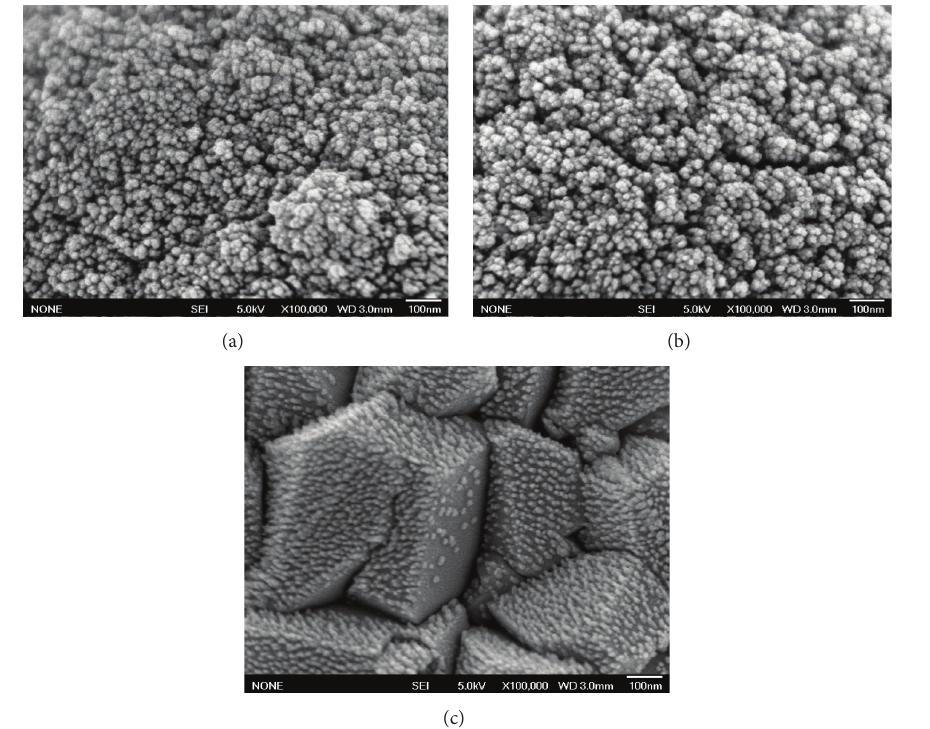
Figure 3: Field emission scanning electron micrographs of synthesized samples. (a) SOD using organosilane, (b) SOD using TPA and CTABr 1: 1, and (c) SOD without